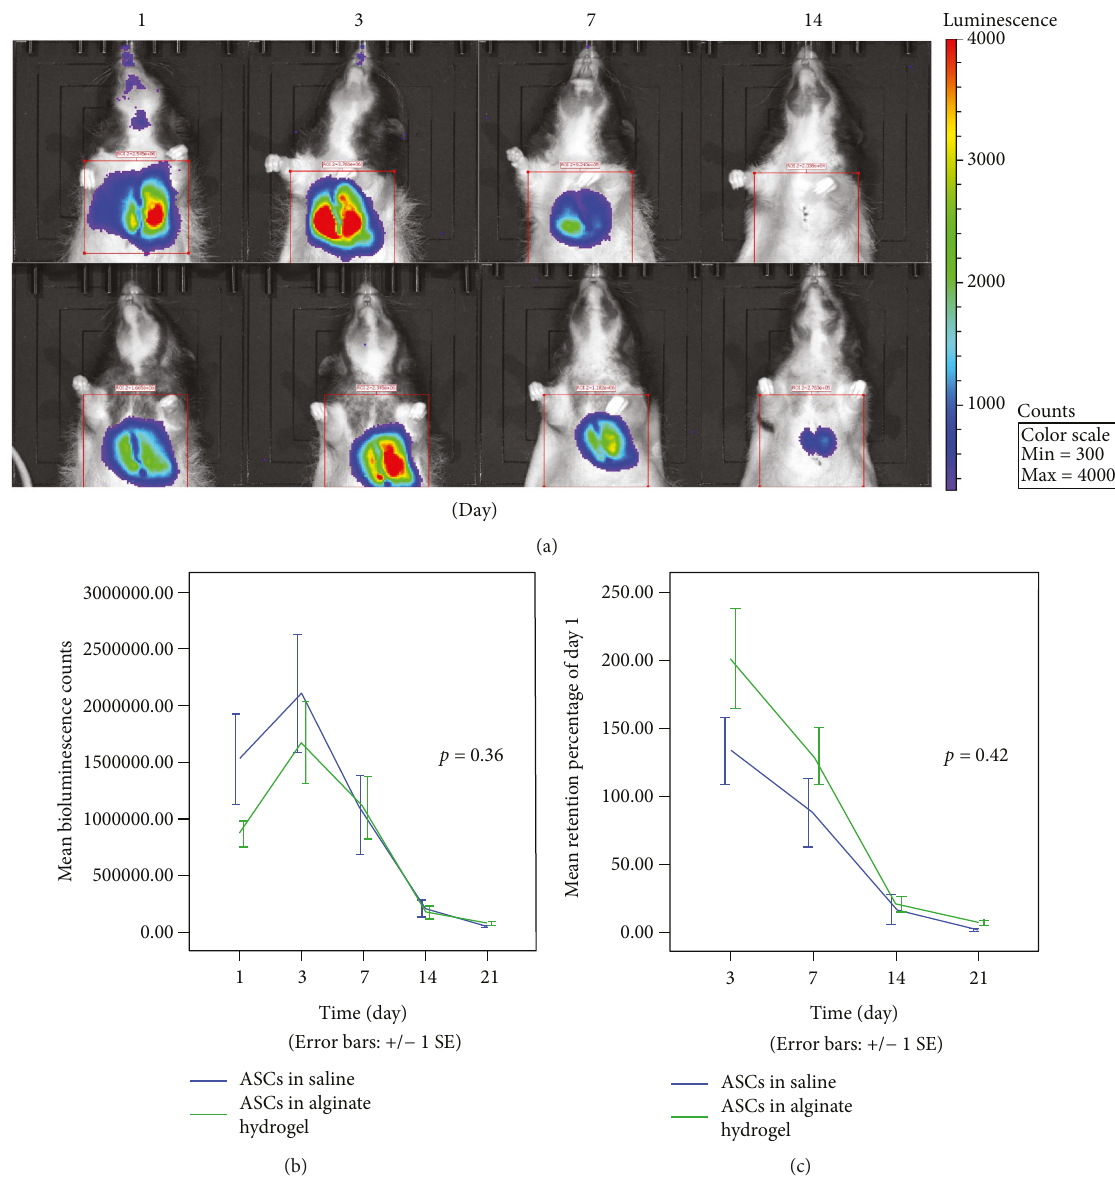
Figure 2: Retention of ASCs. (a) Standardized region of interest on random rats on days 1, 3, 7, and 14 of bioluminescence imaging. (b) Absolute bioluminescence count. (c) Retention of bioluminescent signal compared to day 1. Number of animals for each time point in (b) and (c): days 1, 3, and 7: n = 38 , day 14: n = 24 , and day 21: n = 14 . ASC: adipose-derived stromal cells. p values denote di ff erences in trajectory between the